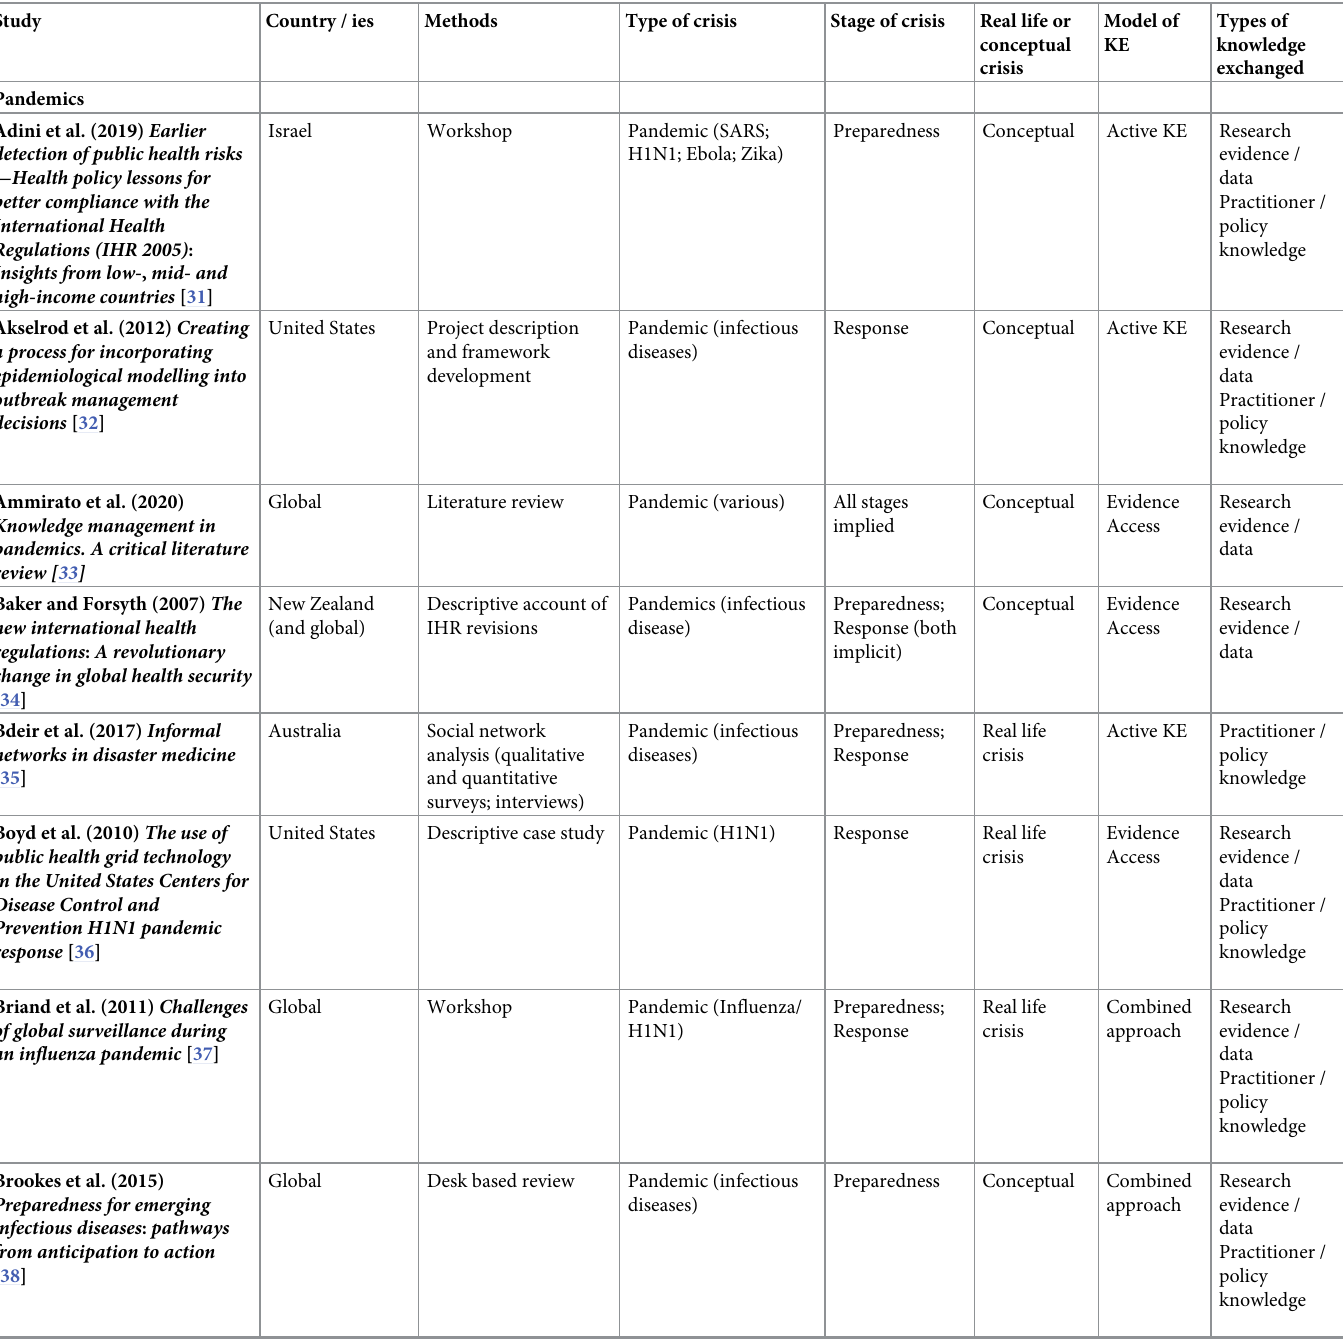
Table 3. Overview of study characteristics by crisis